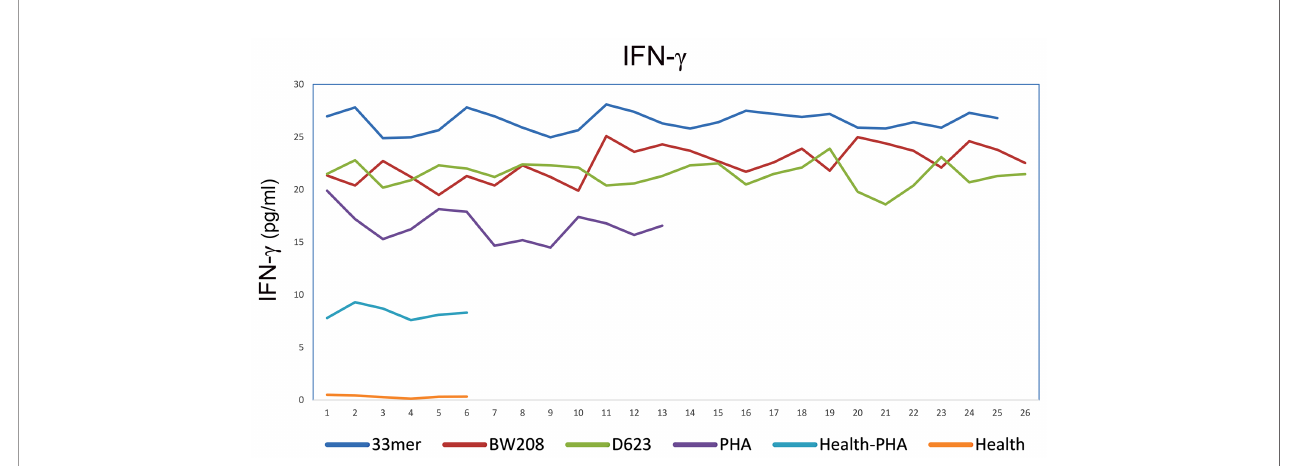
FIGURE 2 | IFN - gamma release by PBMCs of CD patients stimulated with different peptides and PHA as positive control and of healthy controls stimulated and unstimulated with PHA. In axis X the patients and in axis Y the levels of IFN-gamma expressed in